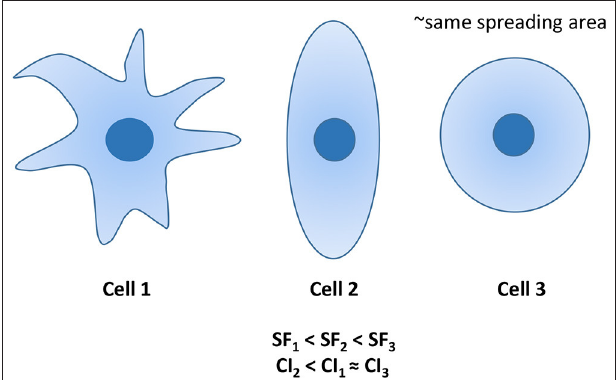
FIGURE 4 | Examples of 3 cells with similar spreading areas, but different morphologies. Cell 1 is characterized by the lowest SF, whereas its CI is similar to that of the circular cell 3. Differently, cell 2 exhibits the lowest CI, whereas its SF is intermediated CI 1 and CI 3